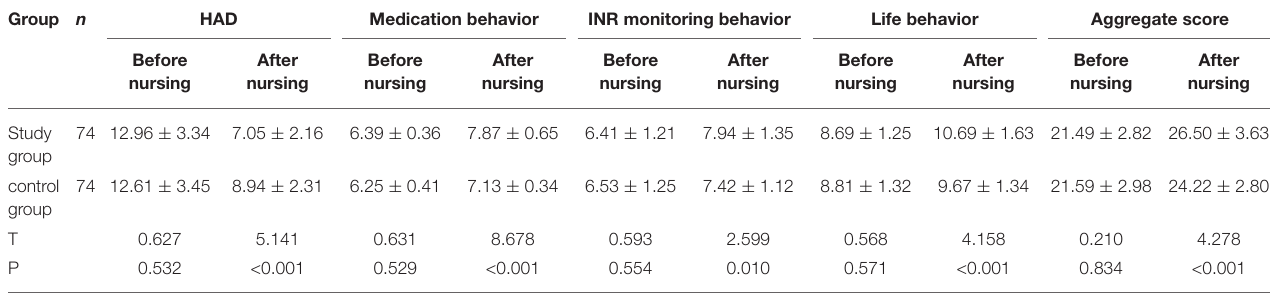
TABLE 4 | Comparison of HAD scores and Compliance Behavior scores of patients with different nursing schemes before and after nursing. Group n HAD Medication behavior INR monitoring behavior Life behavior Aggregate score Before After Before After Before After Before After Before After nursing nursing nursing nursing nursing nursing nursing nursing nursing